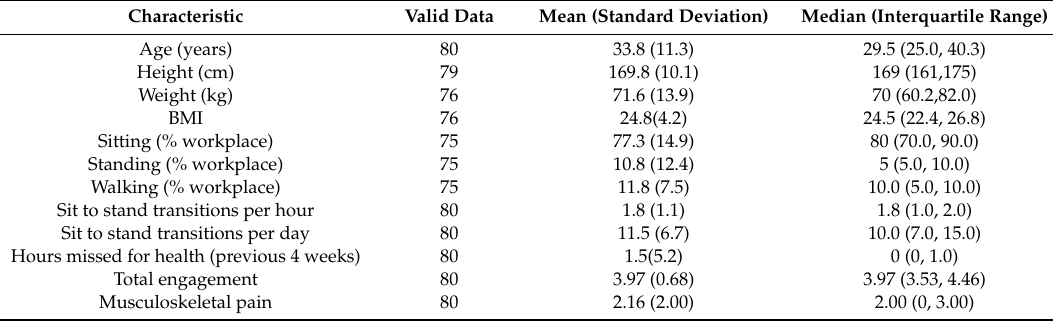
Table 2. Baseline descriptive characteristics of participants.